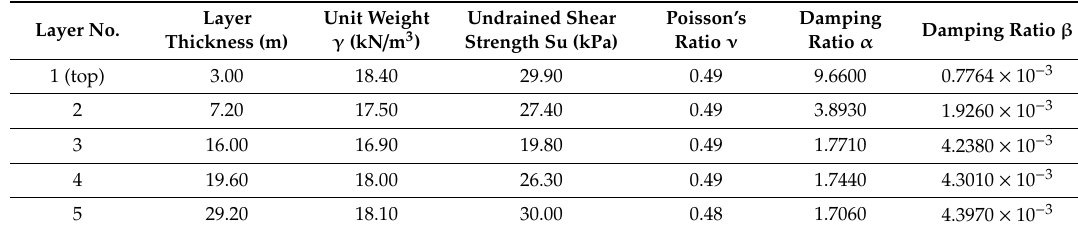
Table 2. Properties of the clay soils.